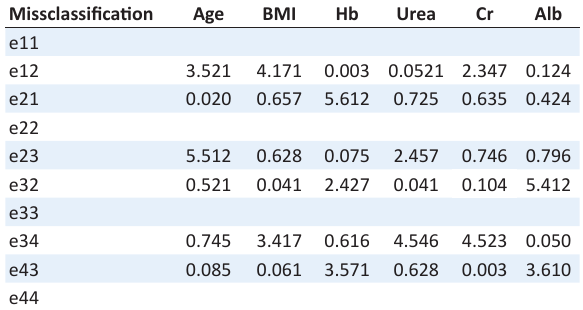
Table 8. Odds ratios for misclassification probabilities under continuous variables